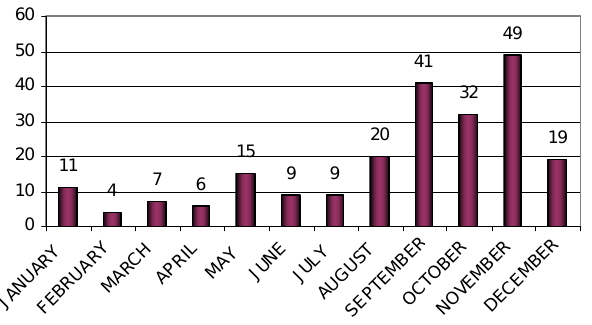
Fig. 2. Monthly distribution of all the flood cases recorded between Fig. 2 . Monthly distribution of all the flood cases recorded between 1990 and 2006. 1990 and